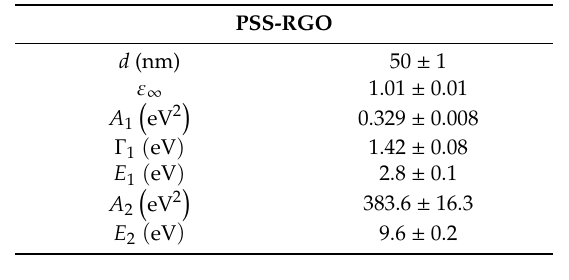
Table2. Lorentzoscillatorsandpoleparametersforreducedgrapheneoxidestabilizedwithpoly(sodium 4-styrenesulfonate) on SiO 2 / Si substrates. Amplitude A k has a unit of eV 2 , center energy E k and broadening Γ k have units of eV; d is the thickness of film in nm; the high-frequency dielectric constant dielectric constant ε ∞ is dimensionless.